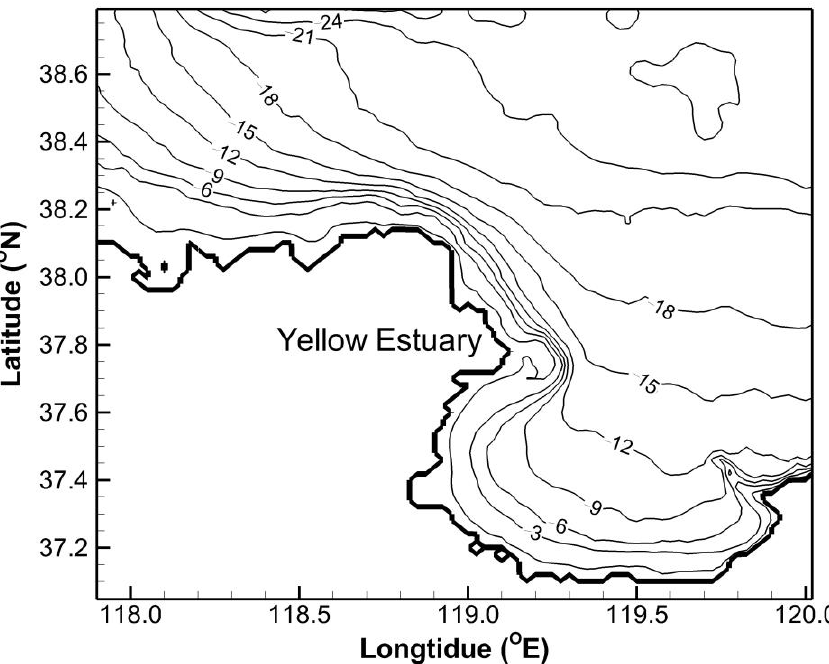
Figure 10. Bathymetry near the Yellow River Estuary, southwest of the Bohai Sea.